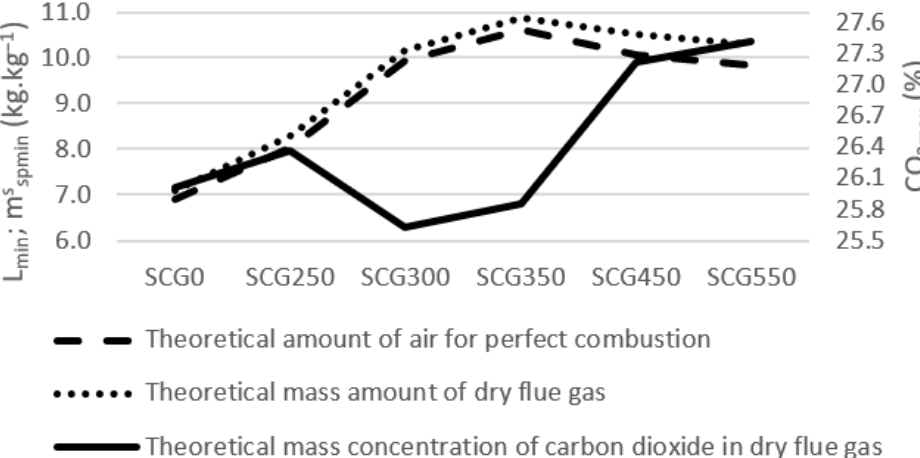
Figure 6. Mass combustion of spent coffee grounds. The theoretical amount of air for perfect combustion L min (kg · kg − 1 ) increased together with the torrefaction degree up to SCG350. There is a slight decrease for SCG450 and SCG550. The same trend has the theoretical mass amount of dry flue gas v fg,min (kg · kg − 1 ) with the highest amount for SCG350. As the amount of air for perfect combustion increases, the CO 2 mass concentration in dry flu gas decreases, CO 2 max (% wt). The decrease in oxygen with the temperature increase caused the CO 2 max (% wt.) decrease for SCG300